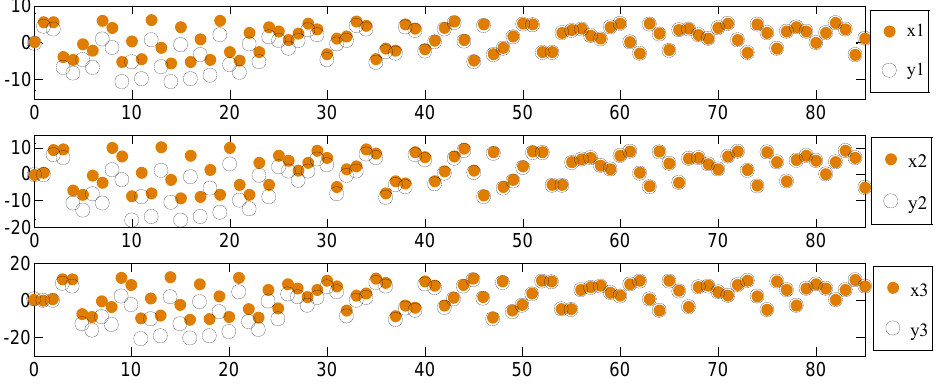
Figure 4. State responses of the controlled master–slave system.